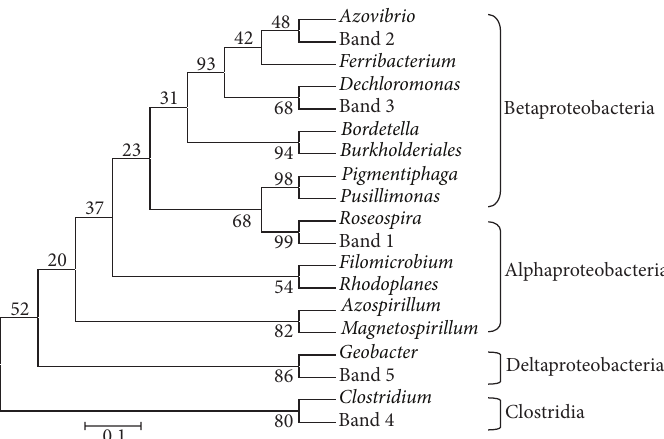
Figure 5: Evolutionary tree, carried out in the software of MEGA version 5.1, of 16S rDNA excised from DGGE showing the phylogenetic affiliations between strains obtained in activated sludge studied here and their closest relatives derived from GenBank.